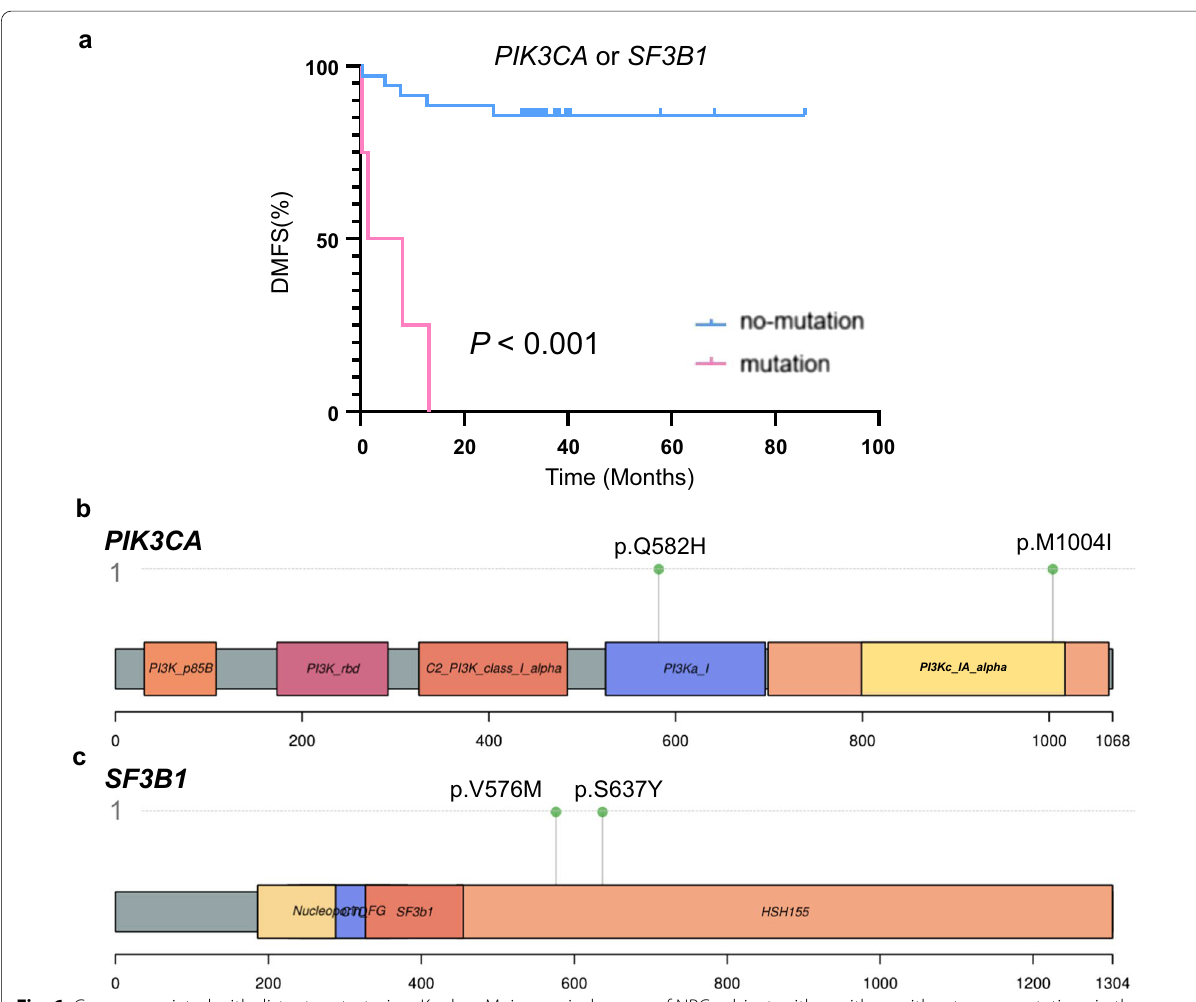
Fig. 6 Genes associated with distant metastasis. a Kaplan–Meier survival curves of NPC subjects either with or without gene mutations in the PIK3CA or SF3B1 . The log-rank test was used to calculate statistical significance. b , c Lollipop plot that depicts the protein mutational distribution and domains for PIK3CA and